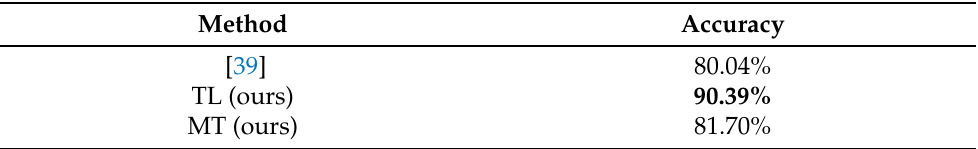
Table 3. Comparison of video patch classification accuracy of our transfer-learning and multitask- learning methods with the one of Amerini et al. [39] on the VISION